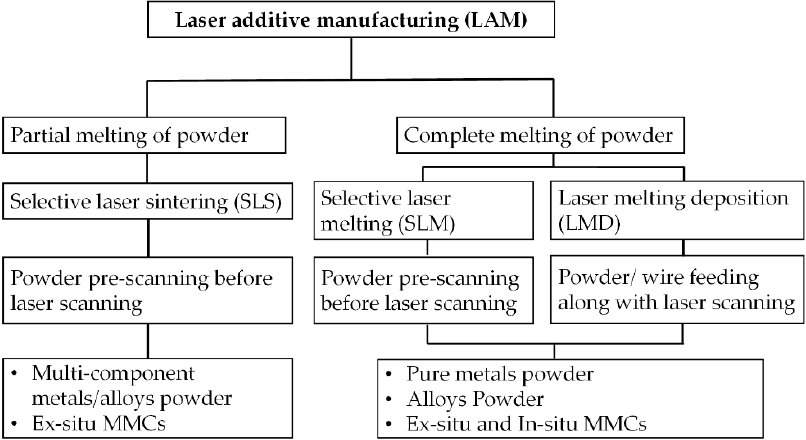
Figure 1. LAM processes classification based on laser-material interaction; based on the data in Ref. [22,39,40].